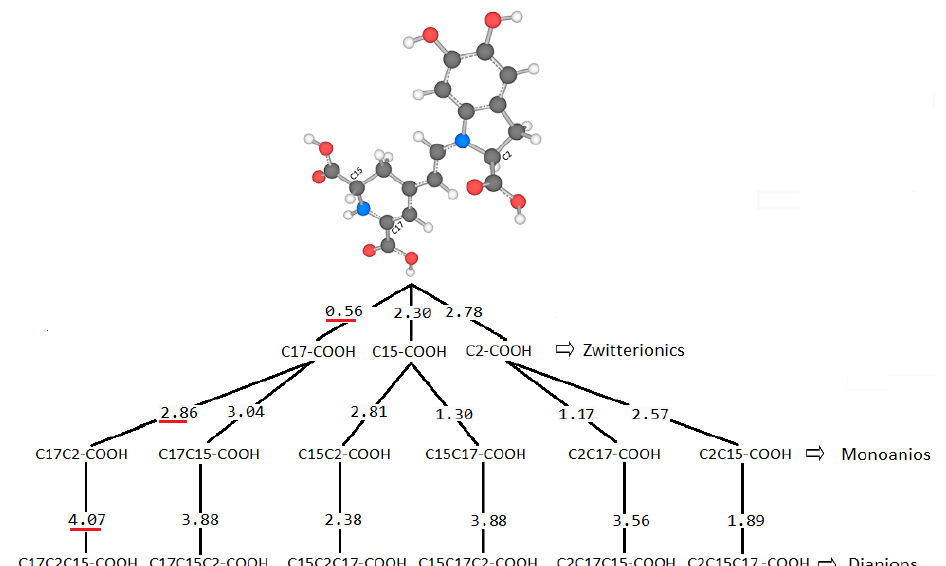
Figure 6. Calculated pK a -values and deprotonation route for carboxyl groups via direct approach.